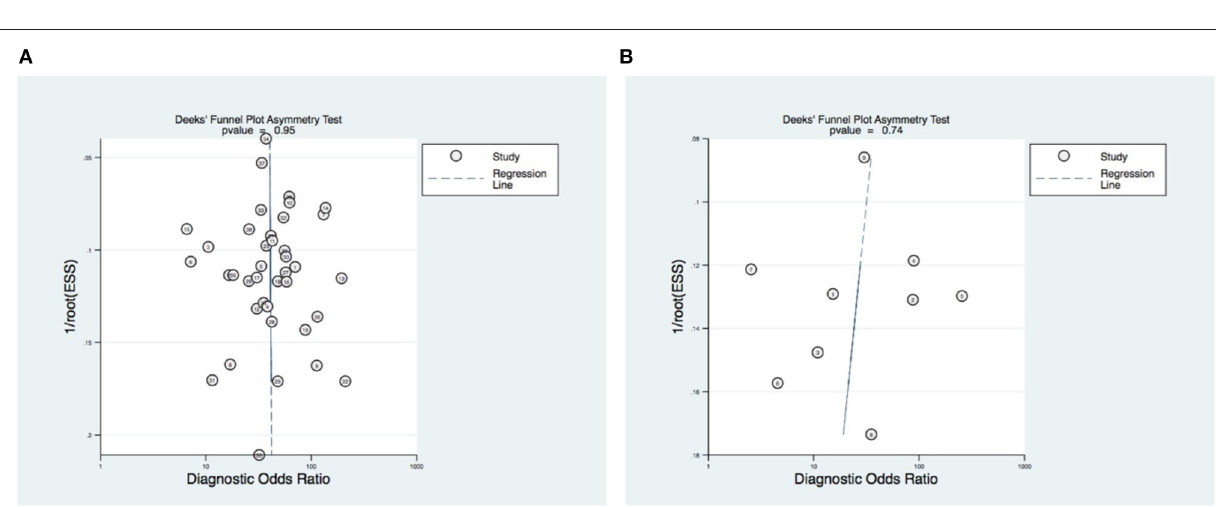
FIGURE 6 | Publication bias assessment. Deek’s funnel plot of (A) pCMR and (B) DSE. The vertical axis displays the inverse of the square root of the effective sample size [1/root(ESS)]. The horizontal axis displays the DOR. P -values < 0.10 indicate non-symmetrical funnel shapes and is suggestive of publication bias. The subimage description at the end is then obsolete ( (A) pCMR. (B)